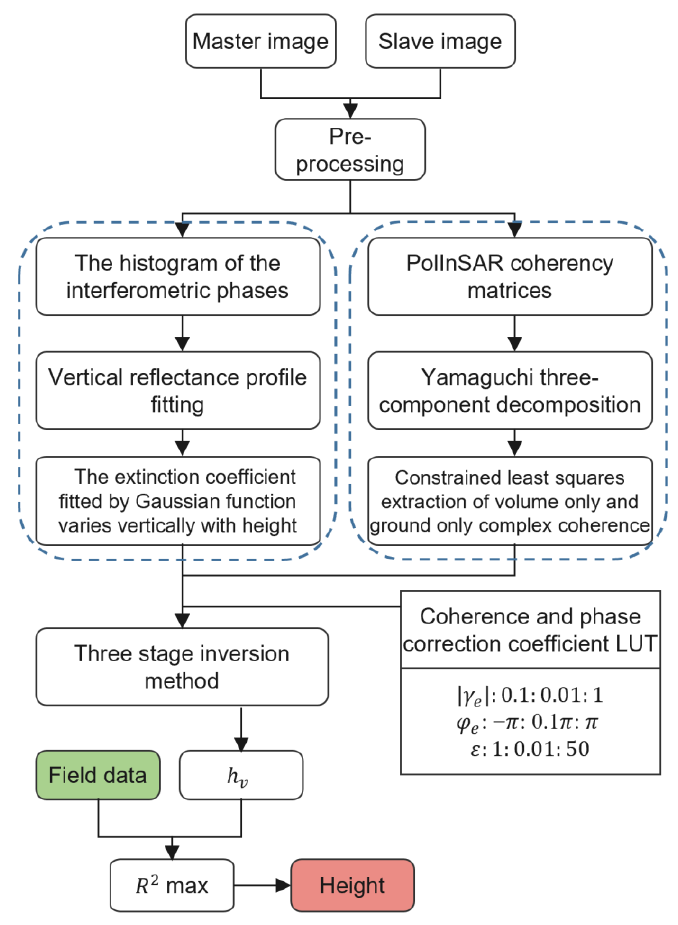
Figure 5. Flowchart of the proposed method employed in this study.